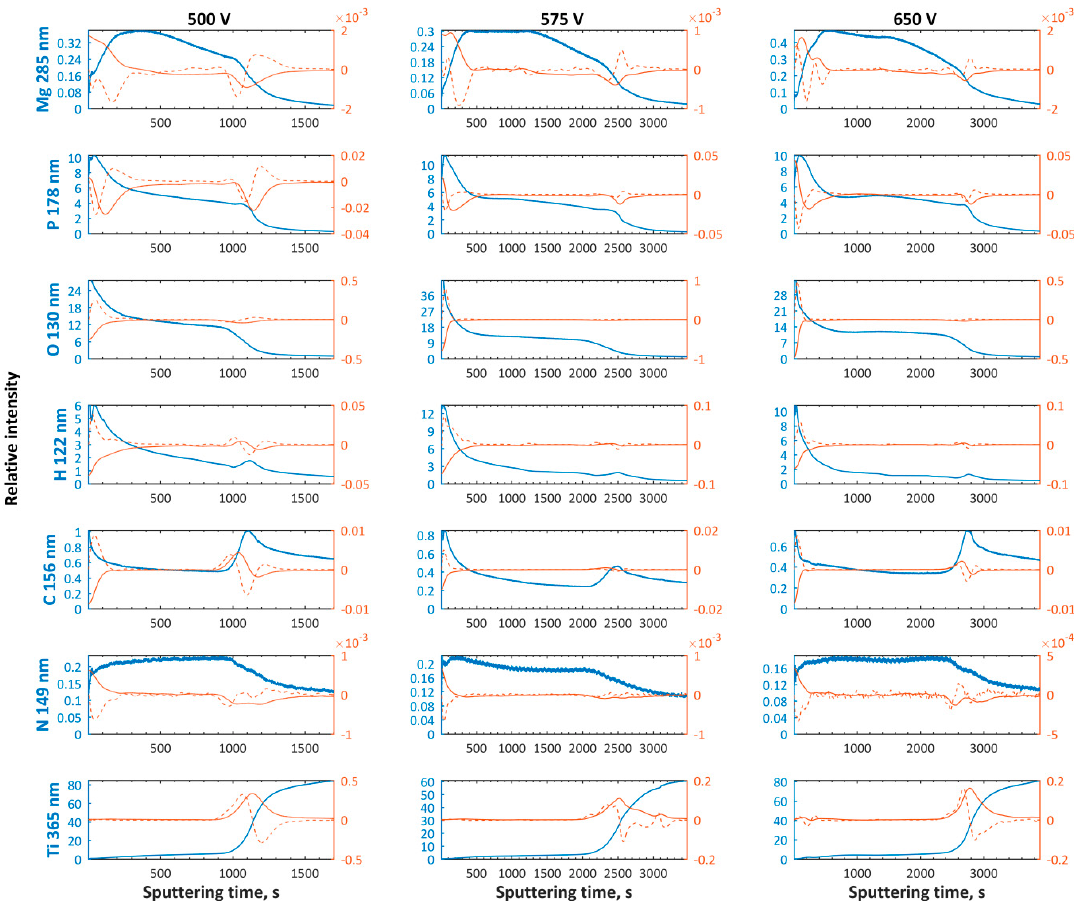
Figure 7. Glow discharge optical emission spectroscopy (GDOES) signals of magnesium (Mg), phosphorus (P), oxygen (O), hydrogen (H), carbon (C), nitrogen (N), and titanium (Ti) of the porous coating formed on CP Titanium Grade 2 after PEO treatment at voltages of 500 V DC , 575 V DC , and 650 V DC in 500 g·L − 1 Mg(NO 3 ) 2 ·6H 2 O in H 3 PO 4 electrolyte; blue continuous line—GDOES signal, red continuous line—first derivative, red dotted line—second derivative.